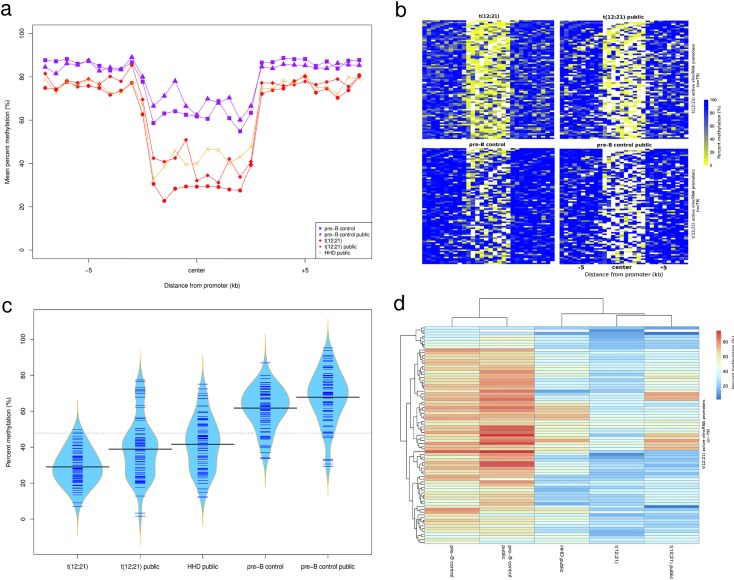
Methylation regulation of t(12;21) active vlincRNA promoters.(a) WGBS mean methylation levels of t(12;21) active promoters (n = 79) in t(12;21), HHD and pre-B control CD10+CD19+ datasets from this study and public data [11]. Each data point represents 10% of promoter size and flanking regions size (±10kb). (b) WGBS methylation heatmap of t(12;21) active promoters in t(12;21) and pre-B control CD10+CD19+ datasets from this study and public data (white = no covered CpGs). Each column represents 10% of promoter size and flanking regions size (±10kb). (c) DNA methylation beanplot of t(12;21) active promoters in t(12;21), HHD and pre-B control CD10+CD19+ datasets from this study and public data. (d) Hierarchical clustering of methylation levels of t(12;21) active promoters in t(12;21), HHD and pre-B control CD10+CD19+ datasets showing similar methylation profiles between this study and public data.